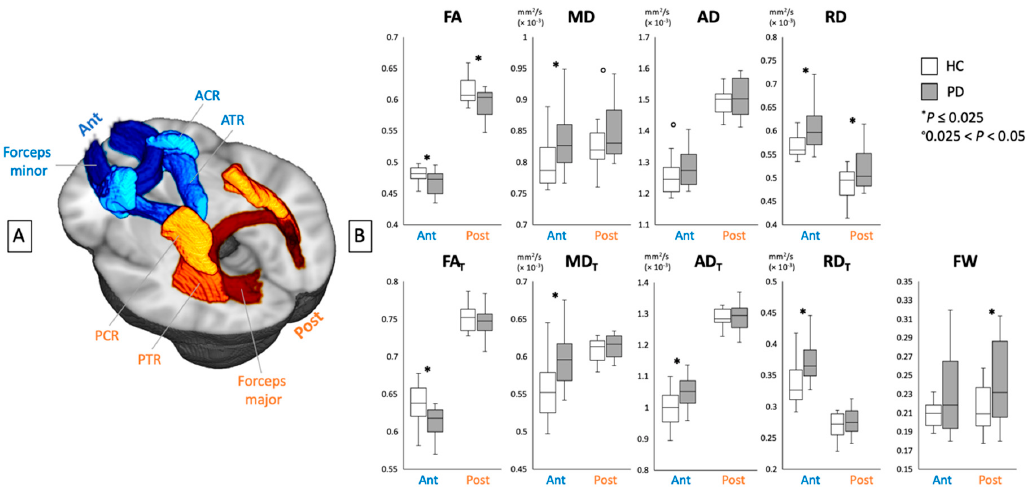
Figure 3. ( A ) Region-of-interest analyses of the anterior (ACR, ATR, and forceps minor) and posterior (PCR, PTR, and forceps major) white matter areas. ( B ) Mean values for DTI (FA, MD, AD, and RD) and FW imaging (FA T , MD T , AD T , RD T , and FW) indices of the anterior and posterior white matter areas in healthy controls (white bars) and patients with PD (gray bars). ACR, anterior corona radiata; AD, axial diffusivity, AD T , FW-corrected axial diffusivity; ATR, anterior thalamic radiation; DTI, diffusion tensor imaging; FA, fractional anisotropy; FA T , free water-corrected fractional anisotropy; FW, free water; HC, healthy controls; MD, mean diffusivity; MD T , free water-corrected mean diffusivity; PCR, posterior corona radiata; PD, Parkinson’s disease; PTR, posterior thalamic radiation; RD, radial diffusivity; RD T , free water-corrected radial diffusivity.